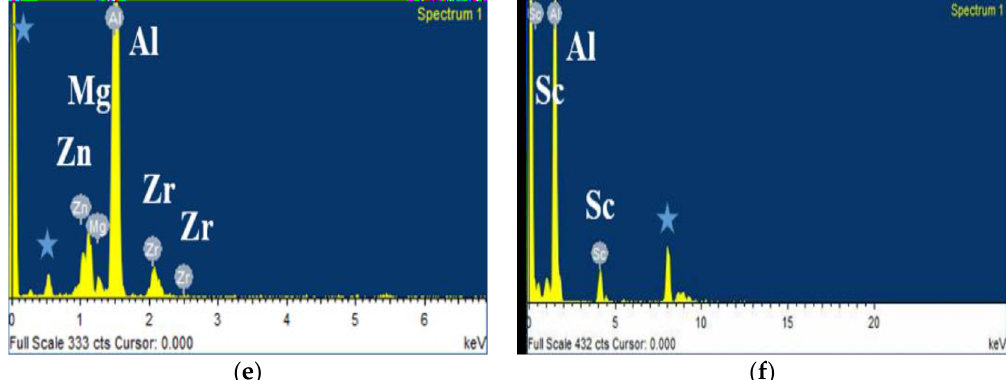
Figure 3. Microstructures observation showing Al 3 Zr (Spherical-like) and Al 3 Sc (Spherical-like) by transmission electron microscope (TEM) analysis of ( a ) 1-Hom. alloy A(0.1Zr); ( b ) 1-Hom. alloy B(0.05Sc); ( c ) 2-Hom. alloy A(0.1Zr); ( d ) 2-Hom. alloy B(0.05Sc); ( e ) EDS analysis of spherical-like particle in alloy A(0.1Zr); ( f ) EDS analysis of spherical-like particle in alloy B(0.05Sc) (asterisks indicate that peaks are possibly omitted).